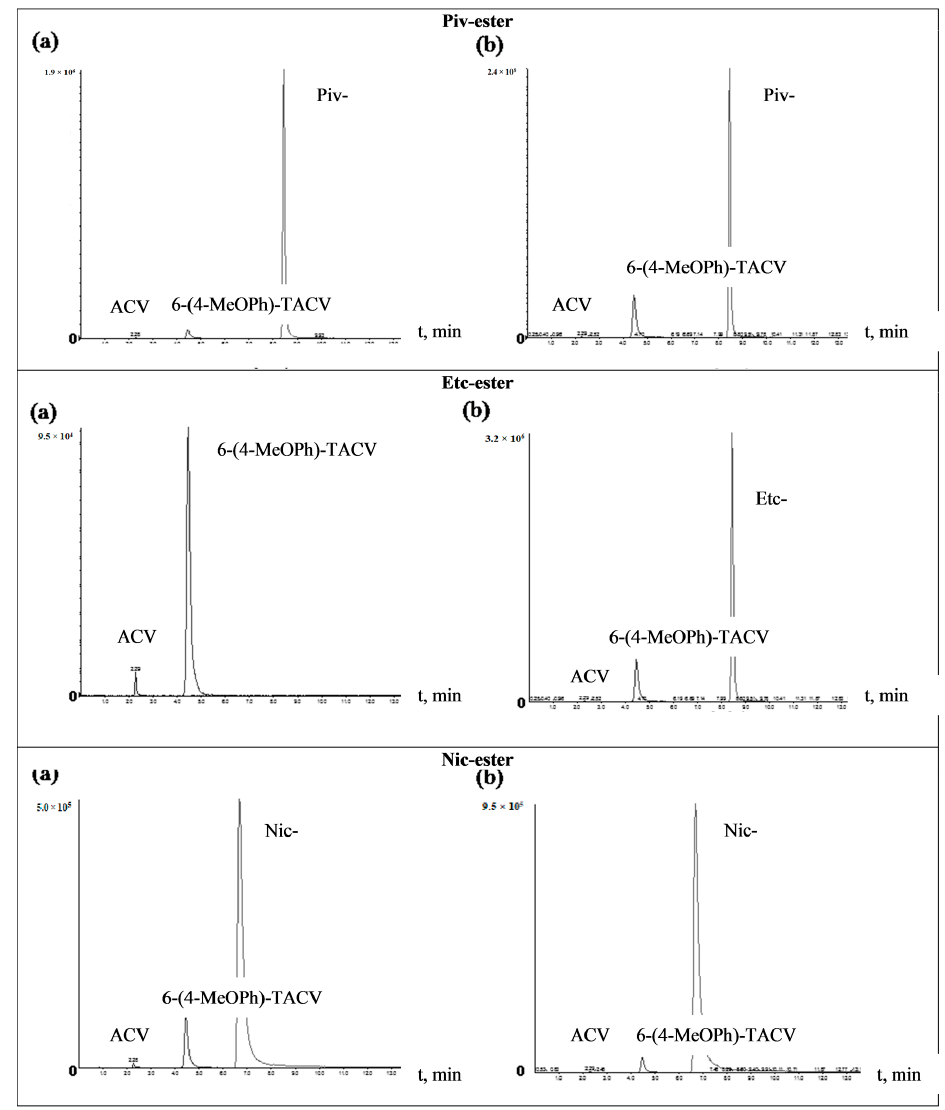
Figure 6. HPLC-MS/MS chromatograms of the 6-(4-MeOPh)-TACV (Piv-, Etc-, Nic-) ester hydrolyzed 37 ◦ C. ( a ) in plasma (80%) for 24 h; ( b ) in plasma (80%) in the presence of porcine esterase (5.50 · 10 − 9 M) at 37 °C. ( a ) in plasma (80%) for 24 h; ( b ) in plasma (80%) in the presence of porcine esterase (5.50 · 10 − 9 for 2 M) for 2 h.